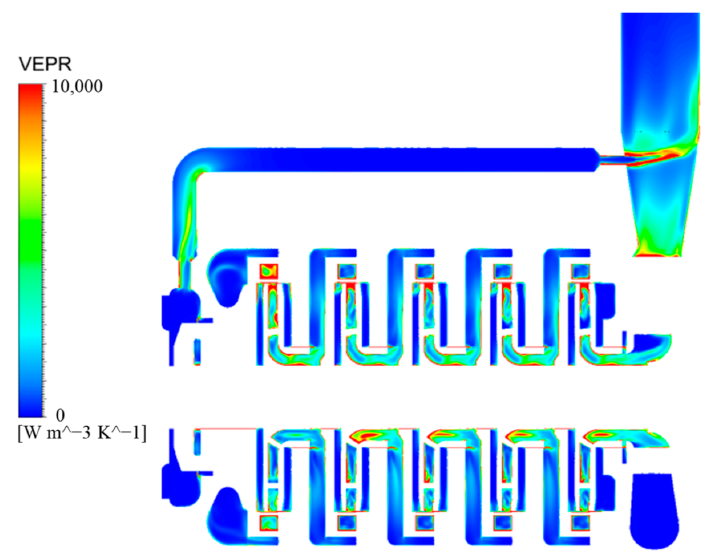
Figure 12. Distribution of VEPR at the mid‑span